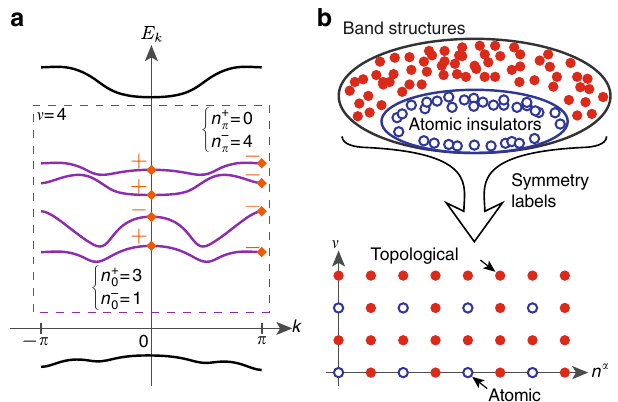
Fig. 1 Symmetry-based indicators of band topology. a Symmetry labeling of bands in a 1D inversion-symmetric example. k 0 = 0, π are high-symmetry momenta, where the bands are either even (+) or odd ( − ) under inversion symmetry ( orange diamonds ). From a symmetry perspective, a target set of bands ( purple and boxed ) separated from all others by band gaps can be labelled by the multiplicities of the two possible symmetry representations, which we denote by the integers n ± . Note that such labeling is insensitive k 0 to the detailed energetics within the set. In addition, the set is also characterized by the number of bands involved, which we denote by ν . Altogether, the set is characterized by fi ve integers, which are further subjected to the constraints ν ¼ n þ n (cid:3) n þ π þ n (cid:3) π . b Symmetry labels 0 ¼ 0 þ like those described in a can be similarly de fi ned for systems symmetric under any of the 230 space groups in three dimensions. Using such labels, one can reinterpret the set of band structures as an Abelian group. This is schematically demonstrated through the two labels ν and n α , which organize the set of all possible band structures into a two-dimensional lattice. Note that the dimensionality of this lattice is given by the number of independent symmetry labels, and is a property of the symmetry setting at hand. Organized this way, the band structures corresponding to atomic insulators, which are trivial by our de fi nition, will generally occupy a sublattice. Any band structure that does not fall within this sublattice necessarily possesses nontrivial band